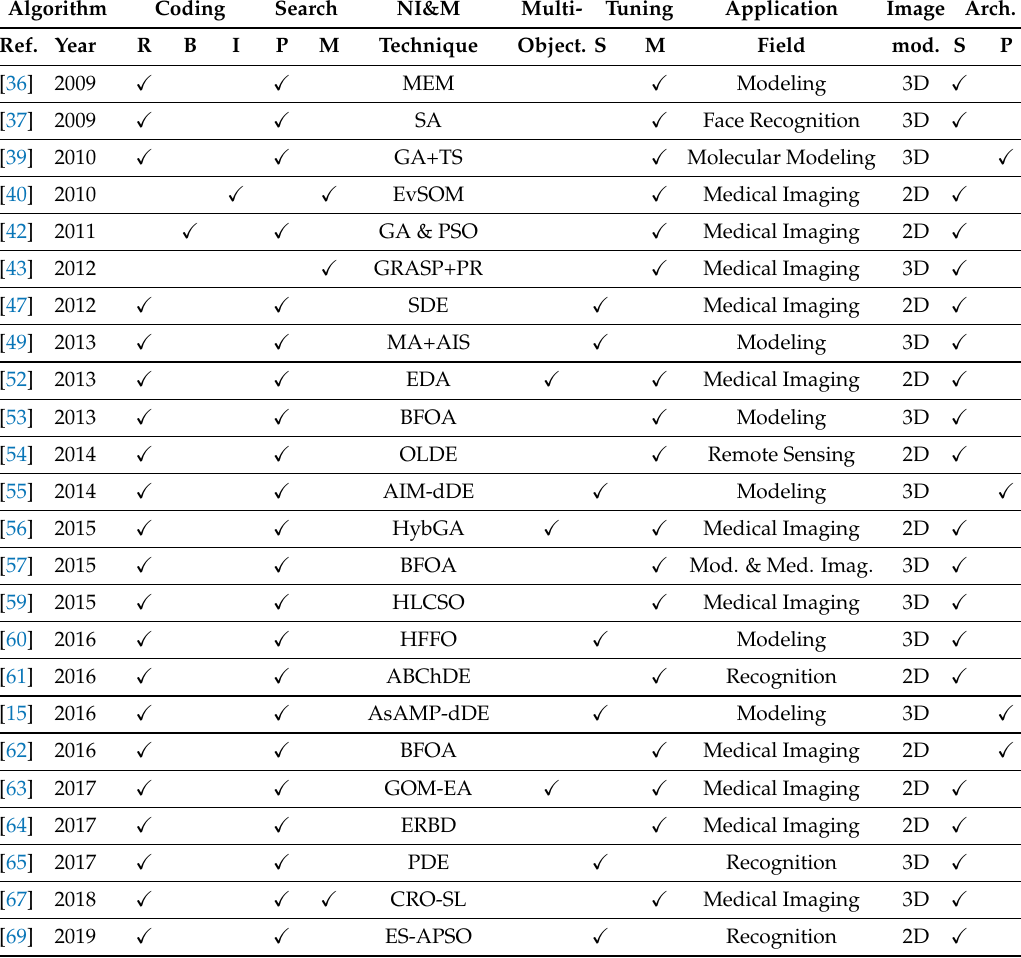
Table 1. The selected twenty-four contributions published along the last decade. Each one is schematized according to eight different features of quality. Algorithm Coding Search NI&M Multi- Tuning Application Image Arch.